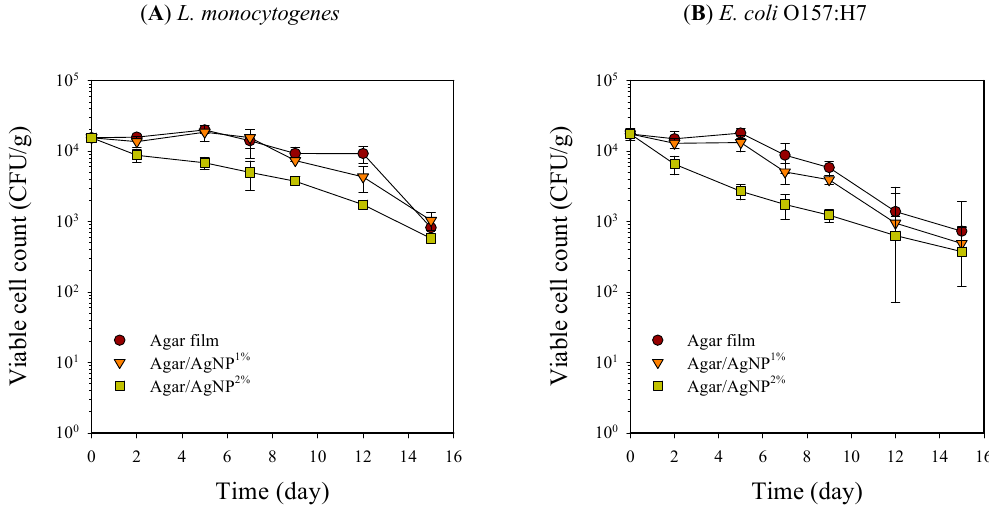
Figure 2. Changes in viable cell counts of L. monocytogenes ( A ) and E. coli O157:H7 ( B ) in beef samples packaged with agar/AgNP composite films. L. monocytogenes : LSD time = 0.09 Log (CFU/g), LSD treatment = 0.06 Log (CFU/g). E. coli O157:H7: LSD time = 0.14 Log (CFU/g), LSD treatment = 0.09 Log (CFU/g).